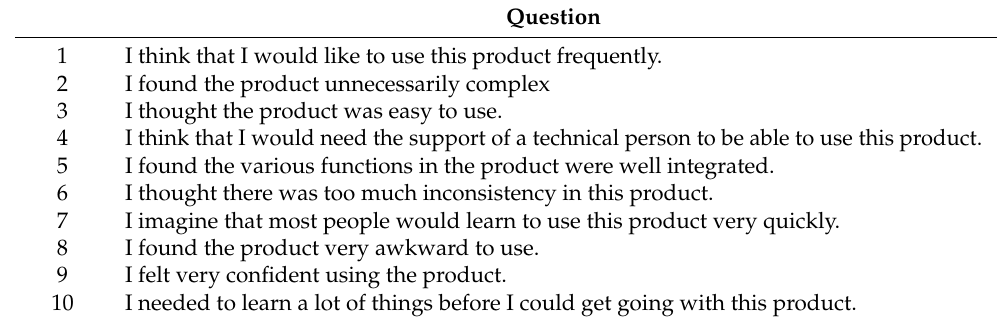
Table 3. System Usability Scale questionnaire (SUS).